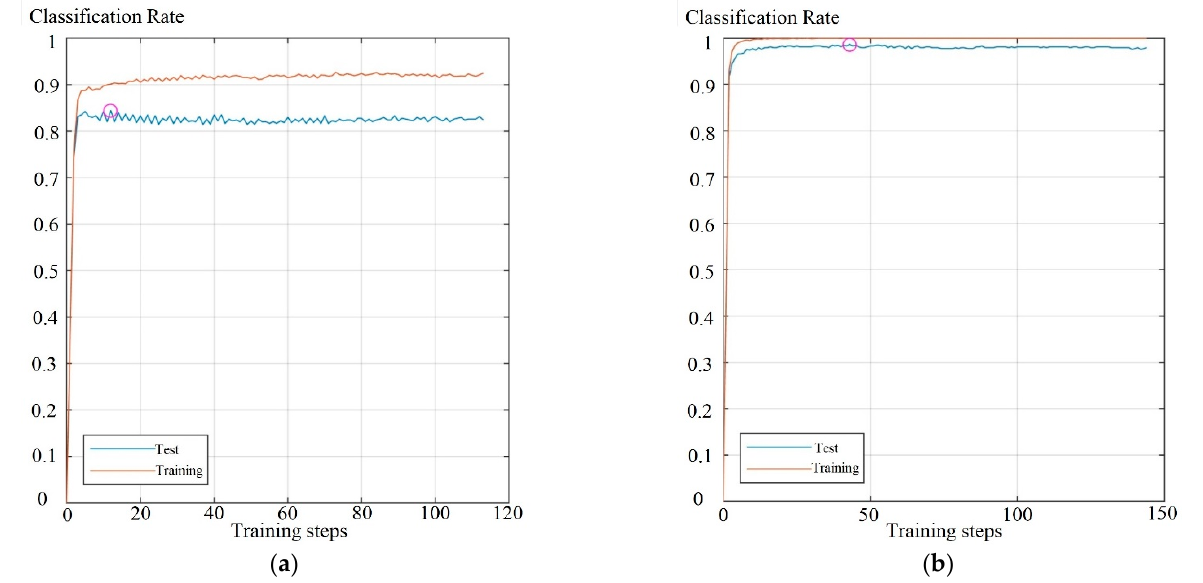
Figure 9. Classification results obtained for a network branch with three cable sections: ( a ) Global classification rate obtained during the test and training phase by using a dataset with four frequencies; ( b ) Global classification rate obtained during the test and training phase by applying the principal component analysis to a dataset with 100 frequencies. Table 7. Summary of the classification results obtained for three cable sections.